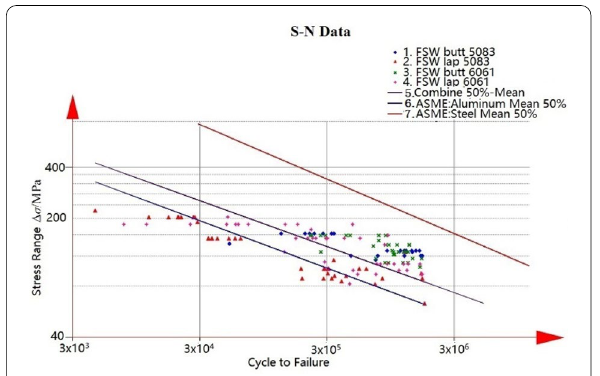
Figure 18 Fatigue life comparison between FSW and base metal using equivalent structural